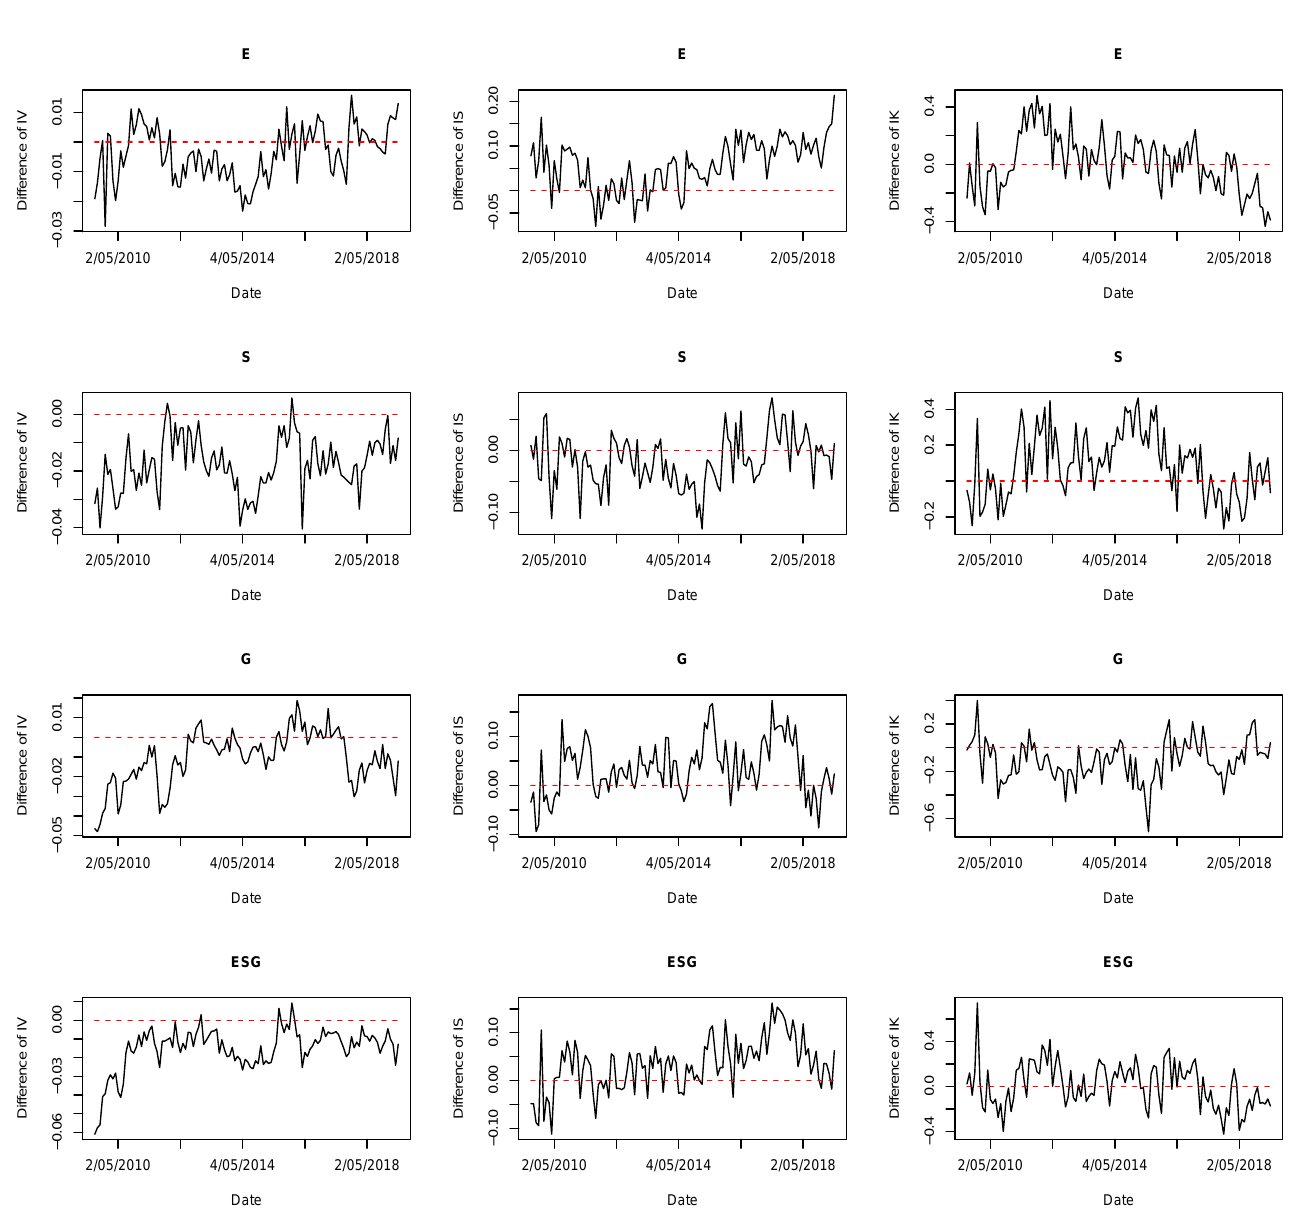
Figure 4. Difference in average implied moments between mid-sized companies in high and low ESG rating